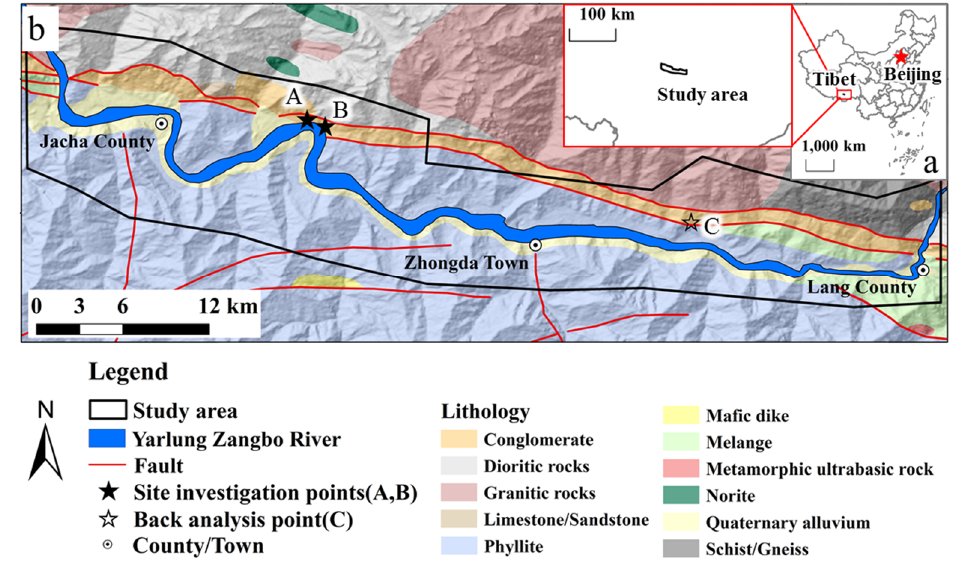
Figure 1. Location and regional geological map of study area ( a ). Location of study area ( b ). Regional geological map of study area (modified from [21,22])).